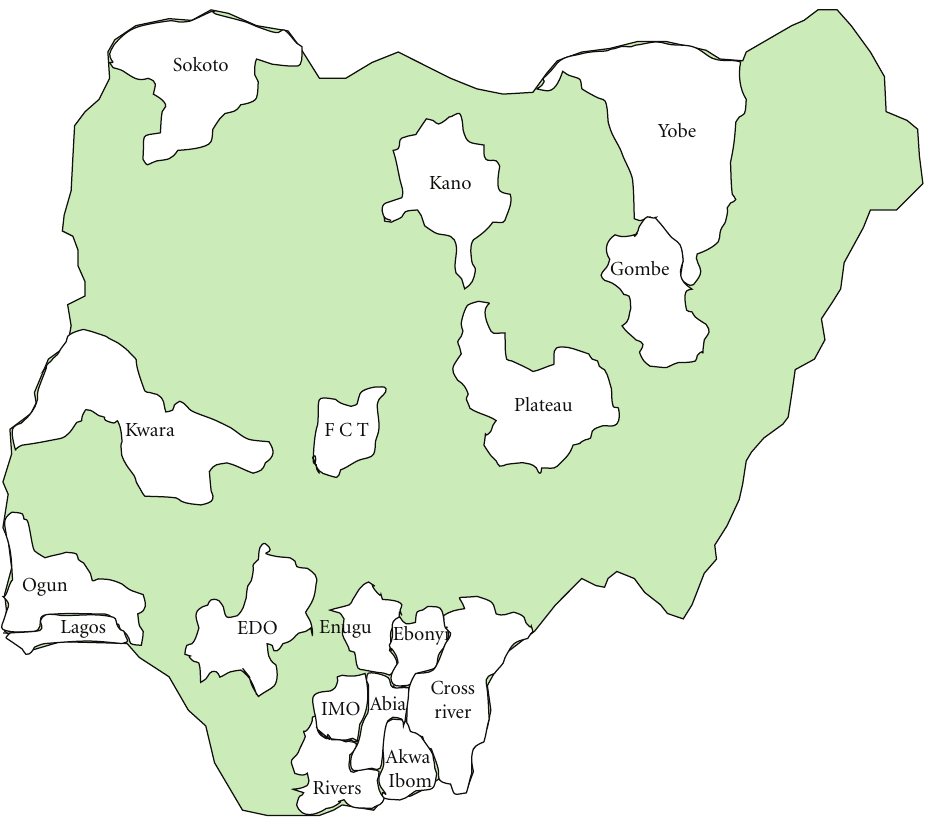
Figure 1: Distribution of the States of Nigeria that host Tertiary Hospitals where RIT intervention had been carried out. The more recent (less than 2 years) hospital entrants in the use of RIT were not included in this study because these lacked the necessary length of RIT service life required in the